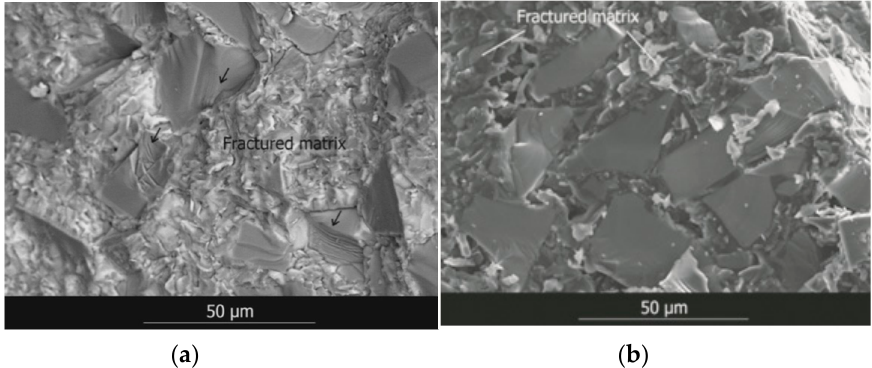
Figure 15. SEM image of the fracture surface of the SiC p / Si composite material after the 3-point bending test ( a ) and after the quasi-static compression test ( b ).